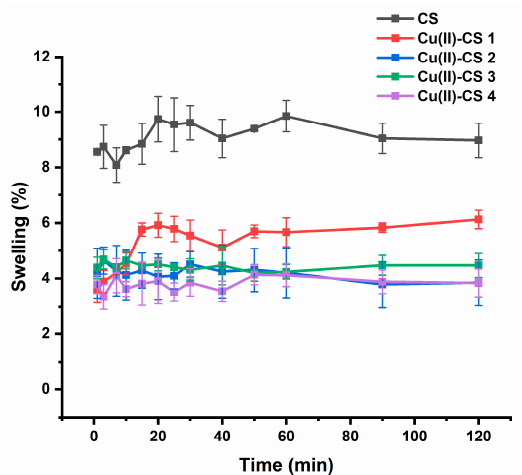
Figure 7. Swelling behaviour of CS and Cu(II)–CS complex coatings with different Cu(II) concentrations with respect to time. Tests were carried out in phosphate buffered saline (PBS).